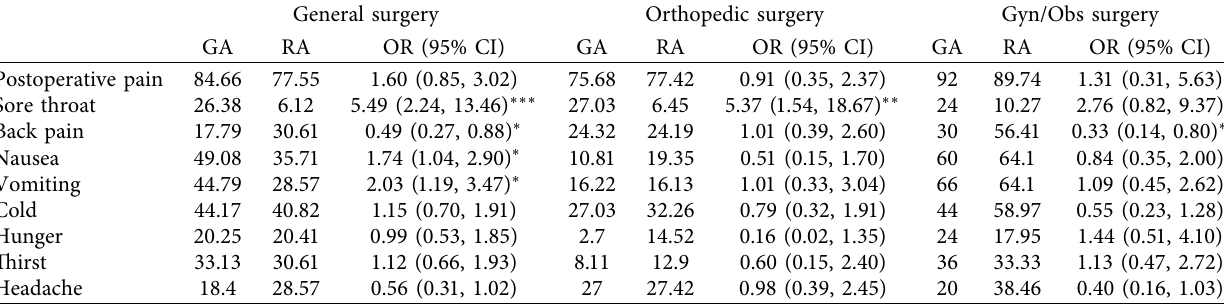
Table 3: Occurrence of undesirable postoperative anesthesia outcomes (types of surgery versus types of anesthesia). General surgery Orthopedic surgery Gyn/Obs